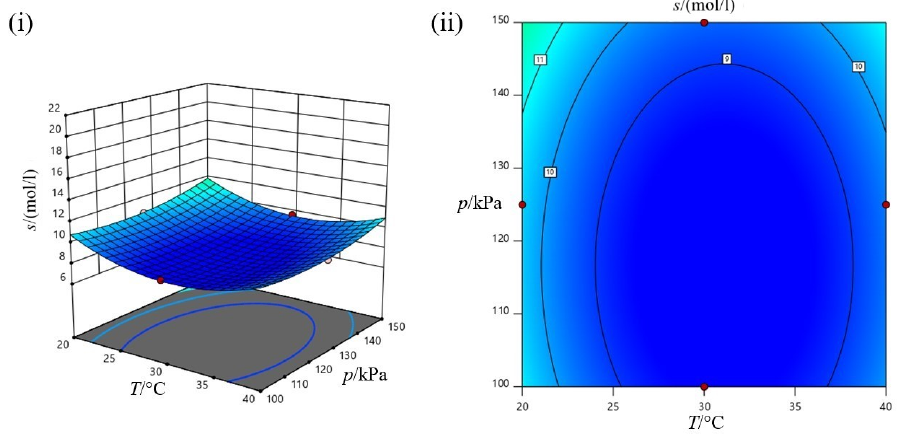
Figure 8. Effect of pressure, temperature and their interaction on CO 2 concentration in culture media with NaOH ( i ) three-dimensional surface plot; ( ii ) projected contour plot.